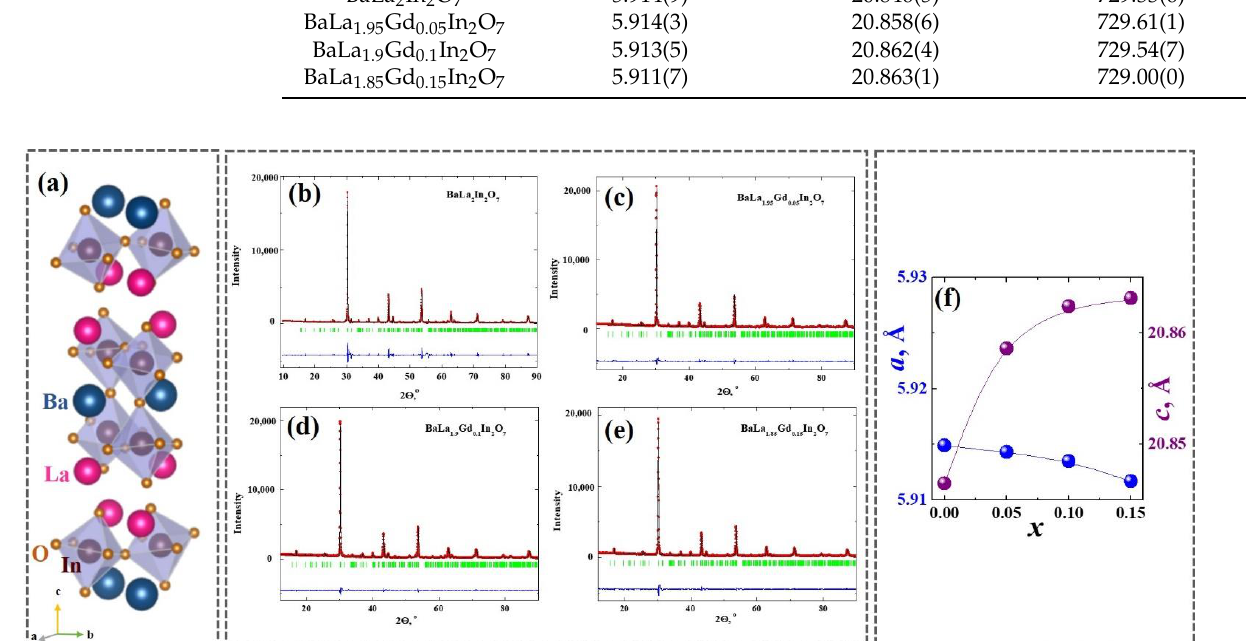
Figure 1. ( a ) Crystal structure of BaLa 2 In 2 O 7 and ( f ) the concentration dependencies of the lattice parameters. XRD-patterns of ( b ) BaLa 2 In 2 O 7 , ( c ) BaLa 1.95 Gd 0.05 In 2 O 7 , ( d ) BaLa 1.9 Gd 0.1 In 2 O 7 and ( e ) BaLa 1.85 Gd 0.15 In 2 O 7 compositions.